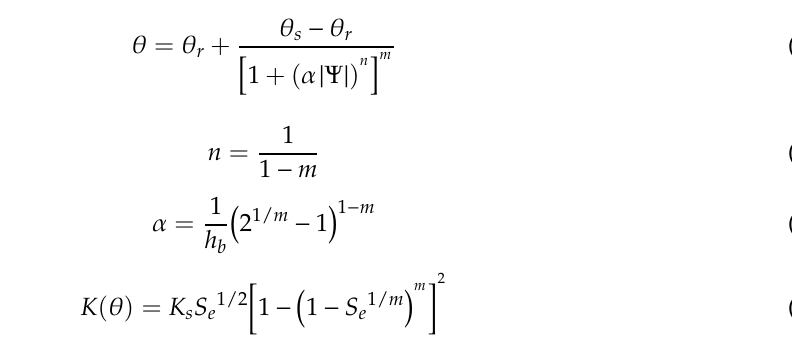
Table 2. Theoretical SWRCs and the estimated values of the unsaturated hydraulic conductivities [26] were constructed and calculated using Equations